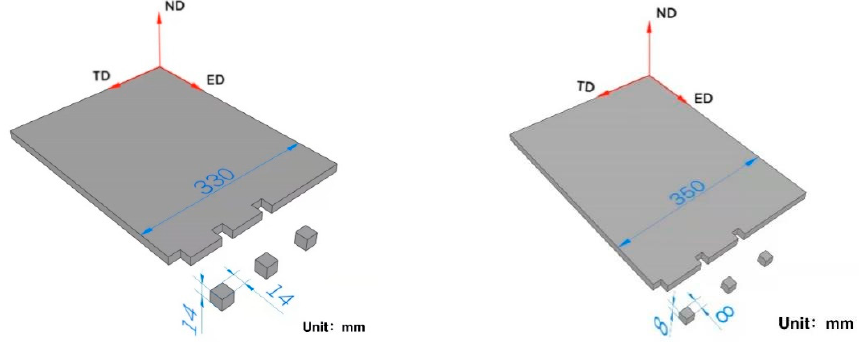
Figure 1. Sketch of sample preparation for texture measurement.